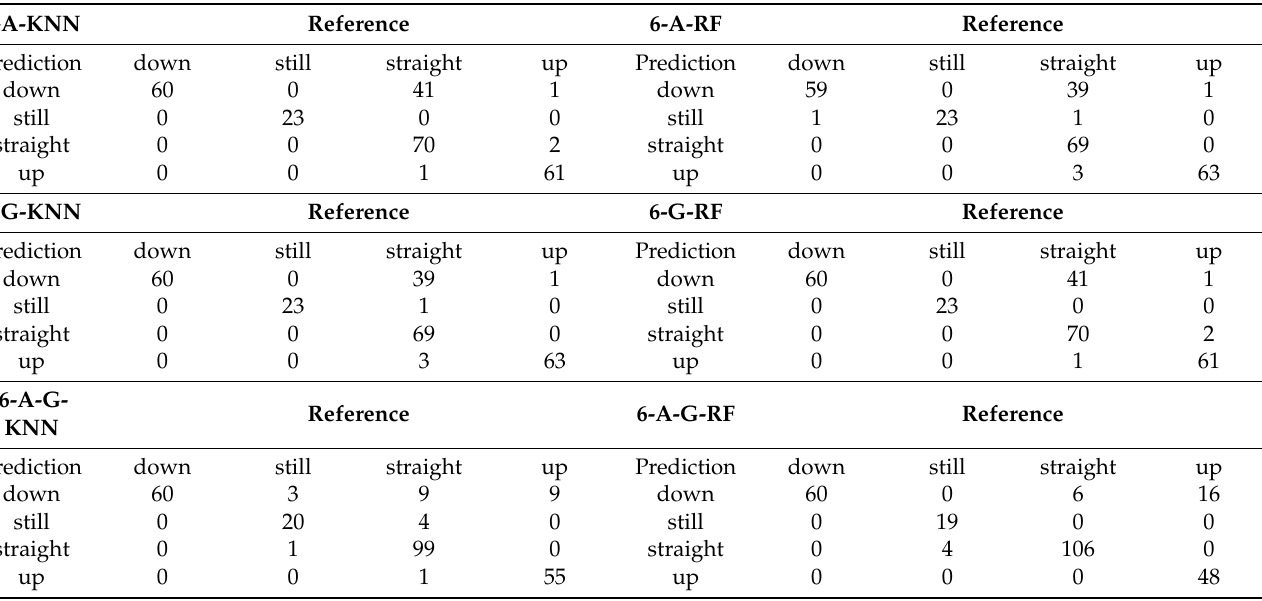
Table 2. No. 6 sensor hoisting activity recognition model.